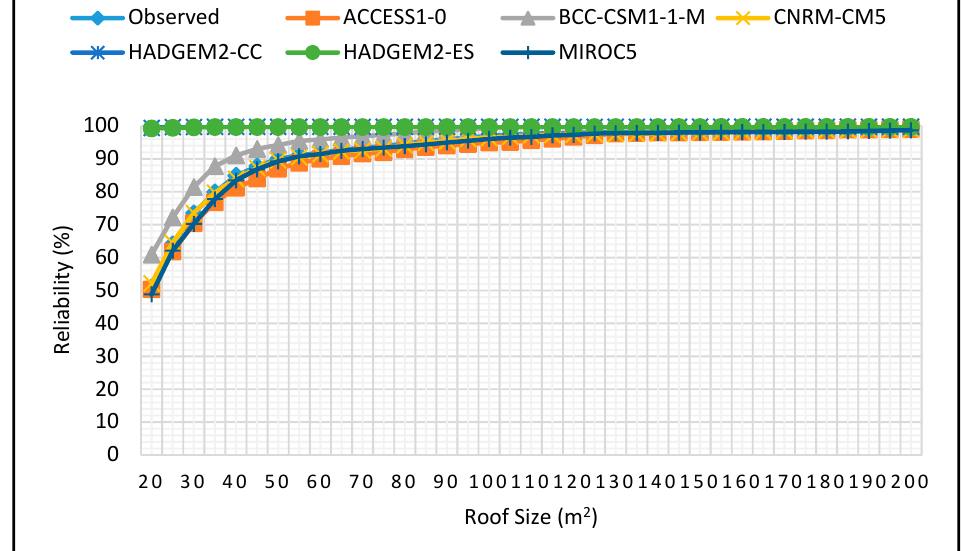
Figure 38. Reliability projections for SON season for 2 m 3 tank size for 2060–2090 period.